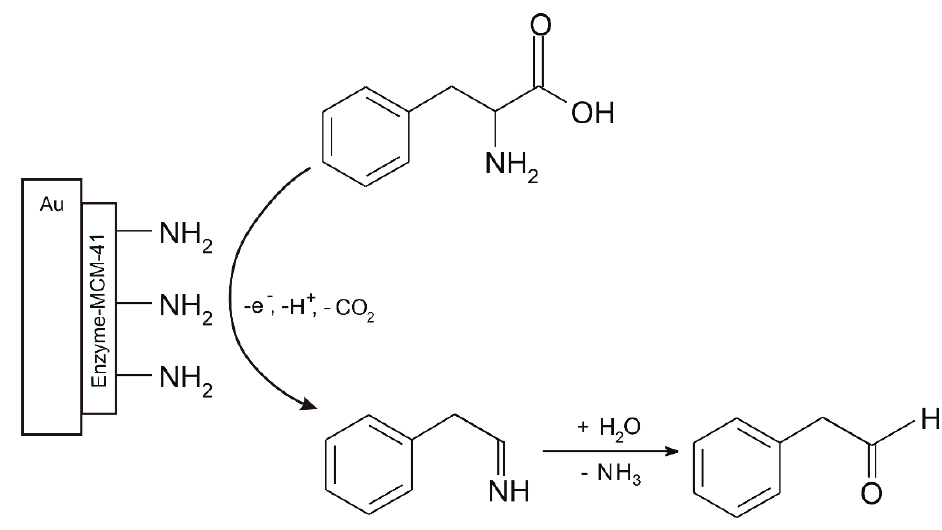
Figure 7. The detection mechanism of the biosensor [64] .